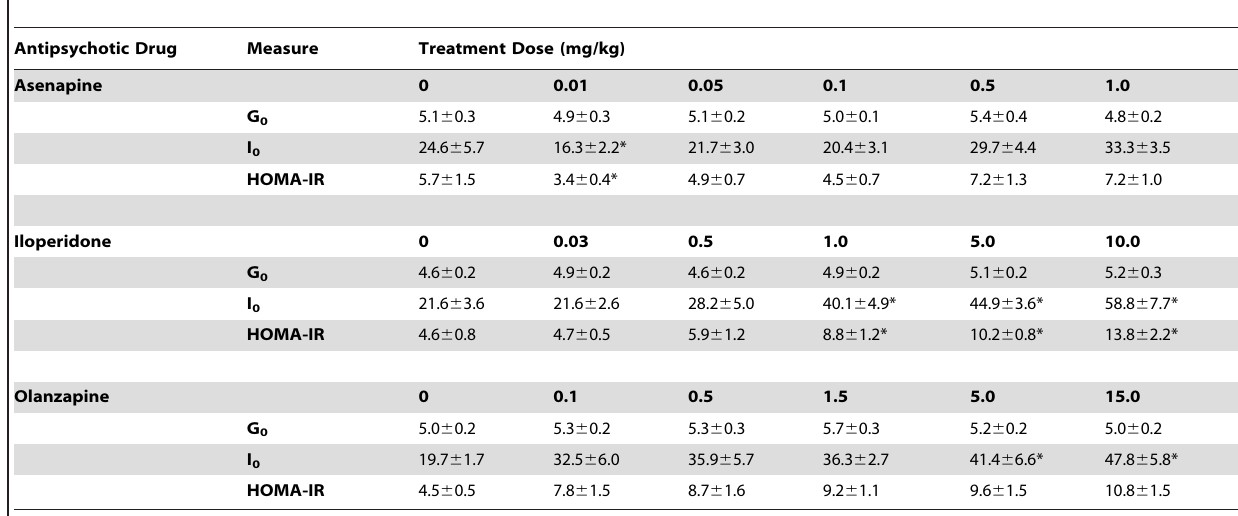
Table 1. Mean concentration of fasting glucose, insulin and HOMA-IR scores in antipsychotic drug treated rats.